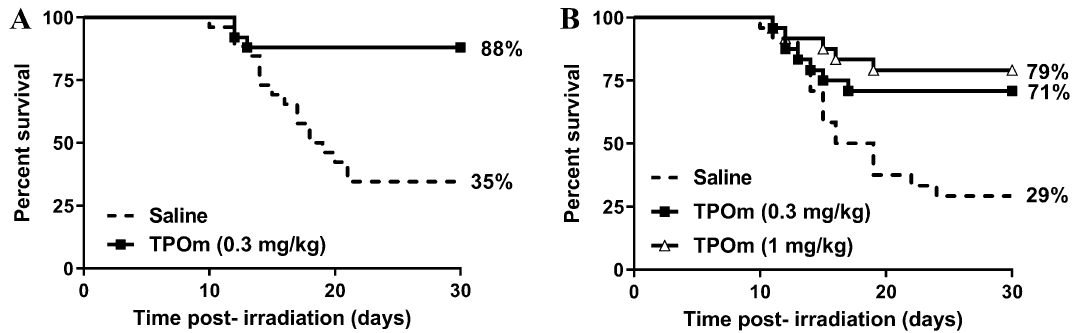
Figure 1. Survival of CD2F1 mice following total body irradiation with 9.35 Gy. A single dose of JNJ- 26366821 at 0.3 mg/kg ( ■ ) or saline as a vehicle (dashed line) was administered 4 h post-TBI ( A ) (Log-rank test p = 0.0002) , a single dose of JNJ-26366821 either at 0.3 mg/kg ( ■ ) or at 1.0 mg/kg (Δ) or saline as a vehicle (dashed line) was administered 24 h post-TBI ( B ) (Log-rank test Saline vs. JNJ-26366821 (0.3 mg/kg) p = 0.0122, Saline vs. JNJ26366821 (1.0 mg/kg) p = 0.0008, JNJ-26366821 (0.3 mg/kg) vs. JNJ-26366821 (1.0 mg/ kg) p = 0.4787. Kaplan–Meier survival curves were plotted using GraphPad software; n = 24 mice per group and trend in survival is compared between vehicle and drug-treated groups. Figures were plotted using GraphPad Prism 9 software V9.0.2; www. graph pad.